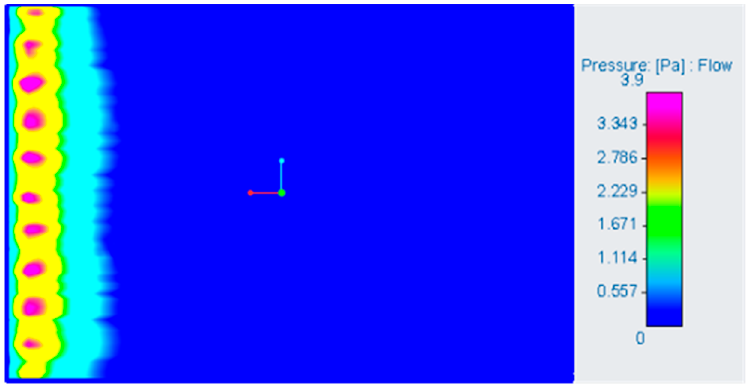
Figure 7. Pressure distribution of the first row of pipes.